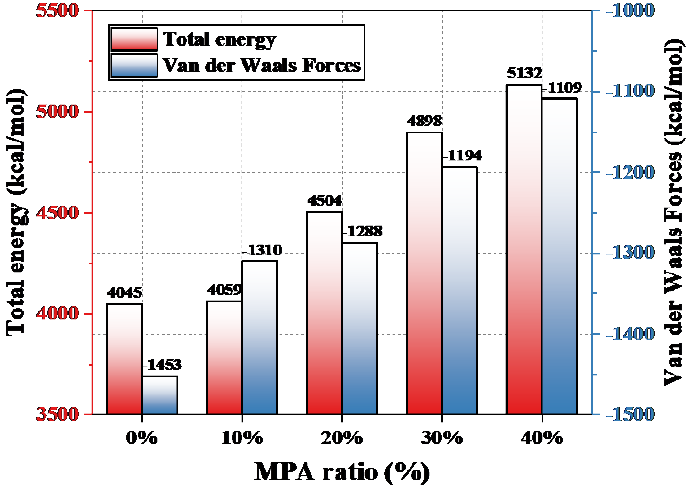
Figure 11. Effects of MPA content on the total energy and van der Waals force.